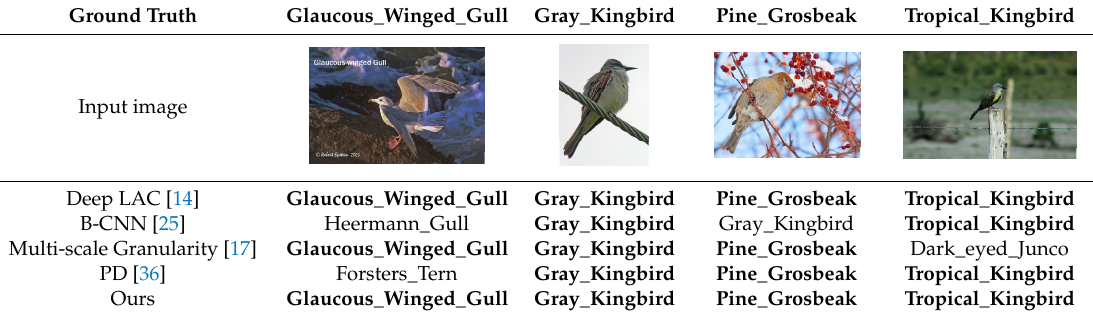
Table 5. Test image results on the CUB 200-2011 dataset: the red text represents misclassification. Ground Truth